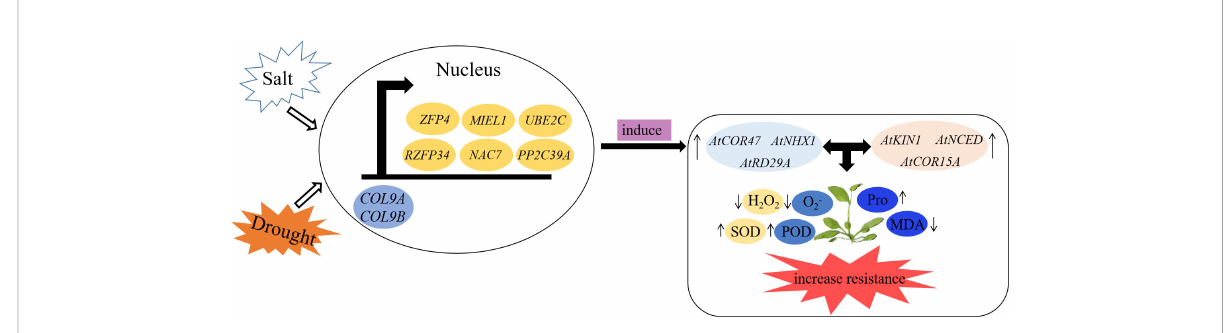
FIGURE 12 A model of MiCOL9 in response to stresses in Arabidopsis . Under salt or drought condition, MiCOL9 interact with stress-relate proteins in nucleus, induced stress endogenous genes and then in fl uenced the changes of relevant physiological indexes. Finally, increased the plants resistance to